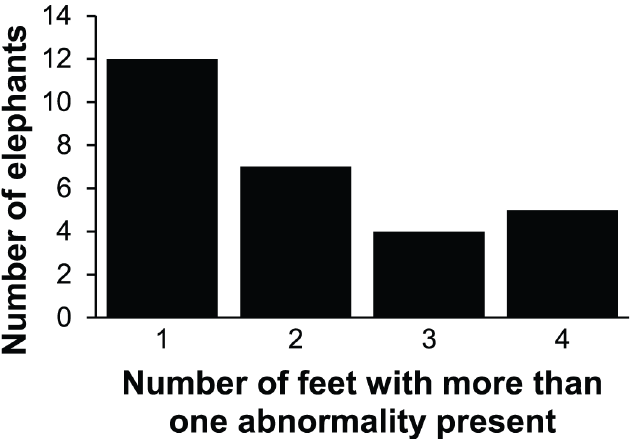
Fig 2. Frequency of elephants with co-localization of foot